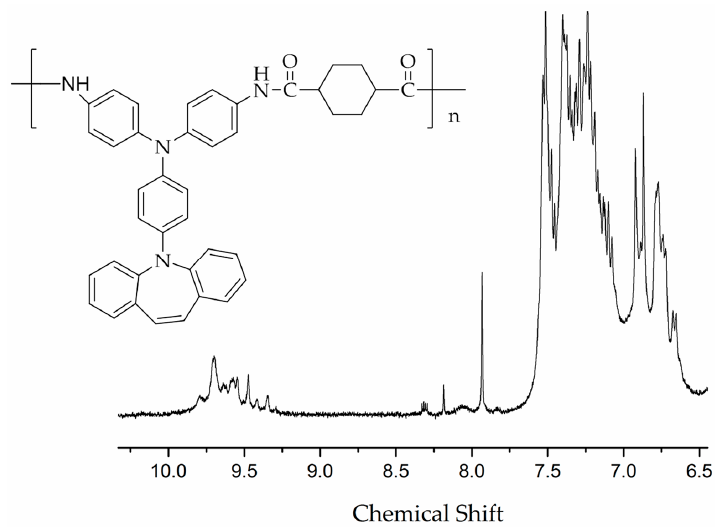
Figure A4. 1 H NMR spectrum of PA–a in DMSO- d 6 .